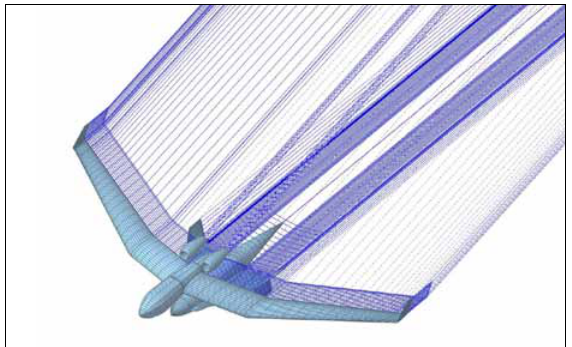
Fig. 3. The computational model (mesh and wake)